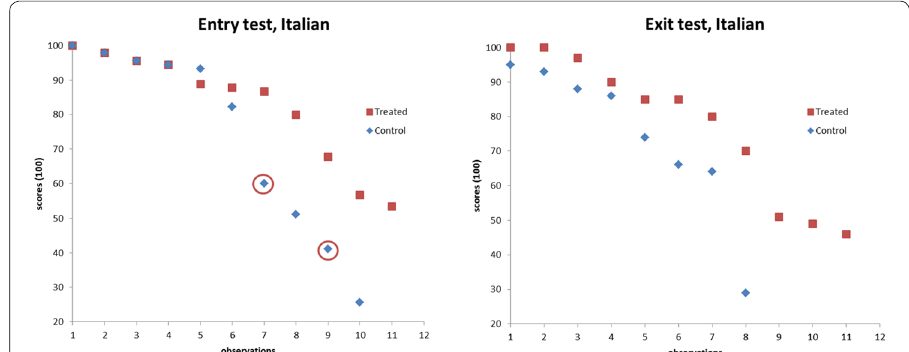
Fig. 1 Italian test scores: pre-treatment (left panel) and post-treatment (right panel) comparing treated vs. non